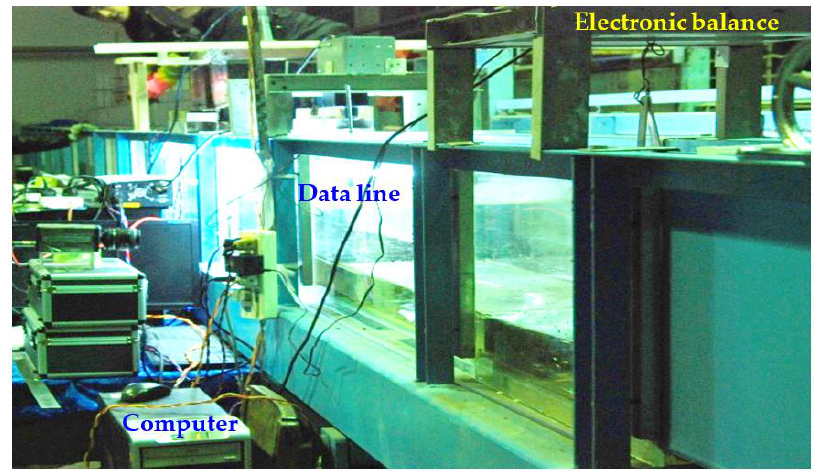
Figure 5. The hardware for data collection and output in SMTM. The data of the bed load weighed by the electronic balance are transmitted to the computer by the data line shown in Figure 5.